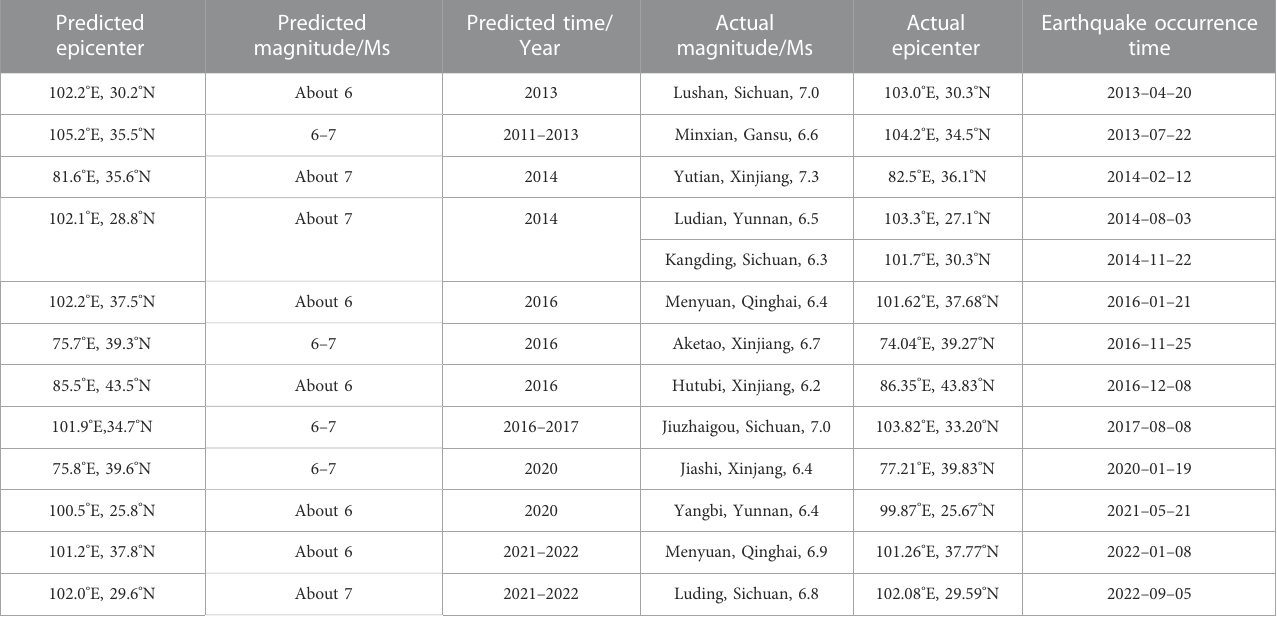
TABLE 2 Midterm prediction information on strong earthquakes with magnitude 6 or above since 2013 (Zhu et al., 2022). Predicted Predicted epicenter